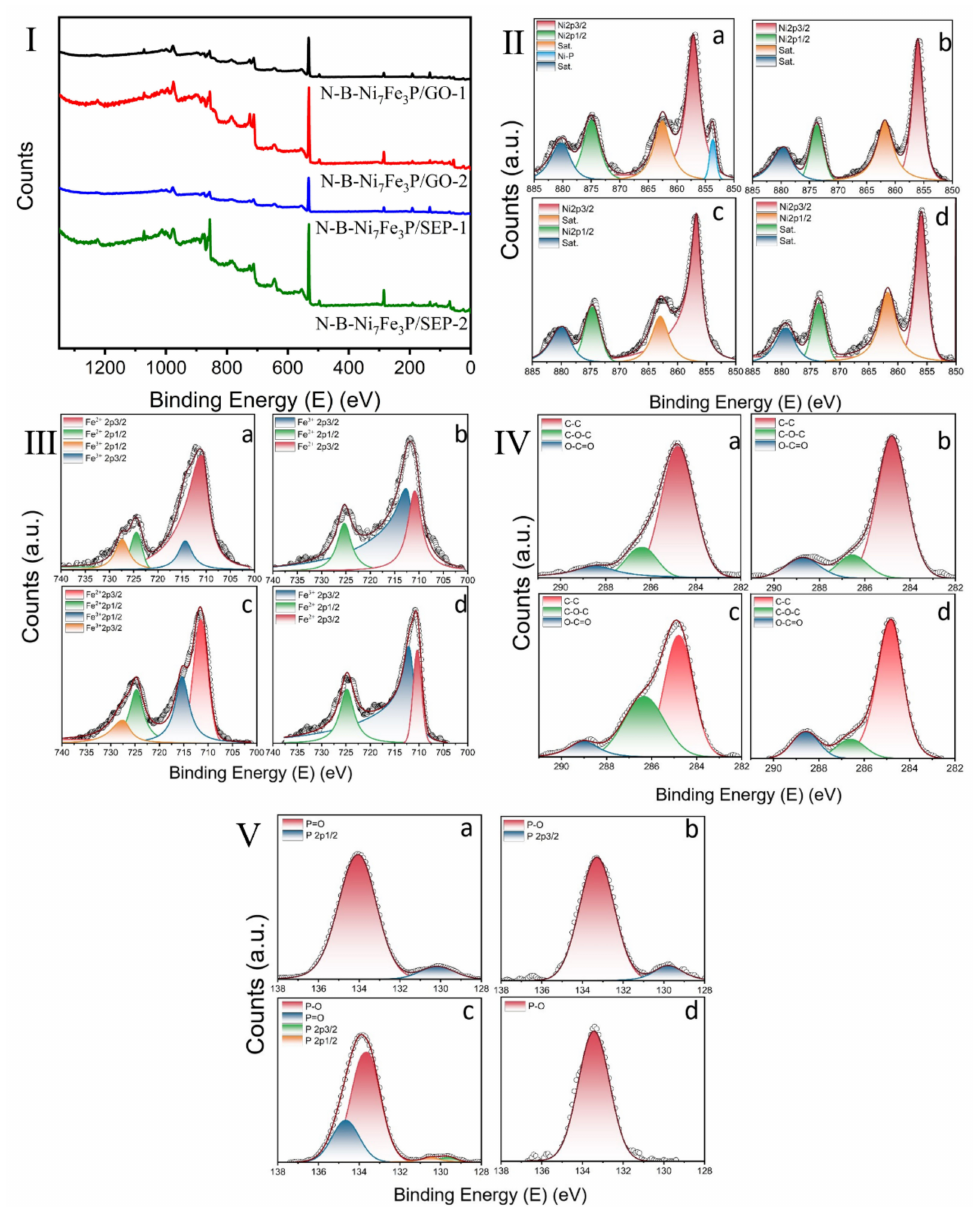
Figure 5. High-resolution XPS spectra (I) of the N-B-Ni 7 Fe 3 P/SEP-1 ( a ), post-catalytic N-B- Ni 7 Fe 3 P/SEP-2 ( b ), N-B-Ni 7 Fe 3 P/GO-1 ( c ) and, post-catalytic N-B-Ni 7 Fe 3 P/GO-2 ( d ); elemental split peak fitting spectra of (II) Ni 2p, (III) Fe 2p, (IV) C 1s, and (V) P 2p. The peaks at 711.5 eV and 724.6 eV were assigned to Fe 2p3/2 and Fe 2p1/2 of